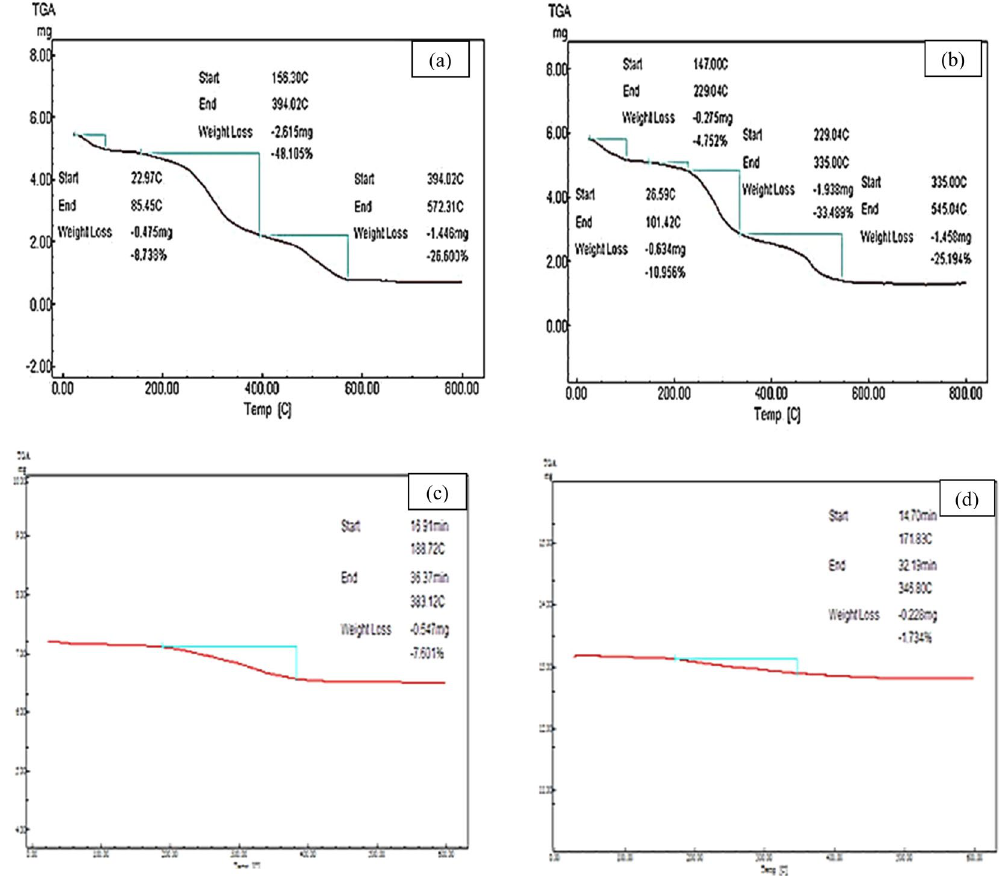
Figure 4. Thermal gravimetric analysis of two raw water hyacinth segments, raw shoots and roots: ( a ) shoots segment, ( b ) roots segment, ( c ) prepared Nano-activated carbon, ( d ) magnetic activated carbon nano-hybrid